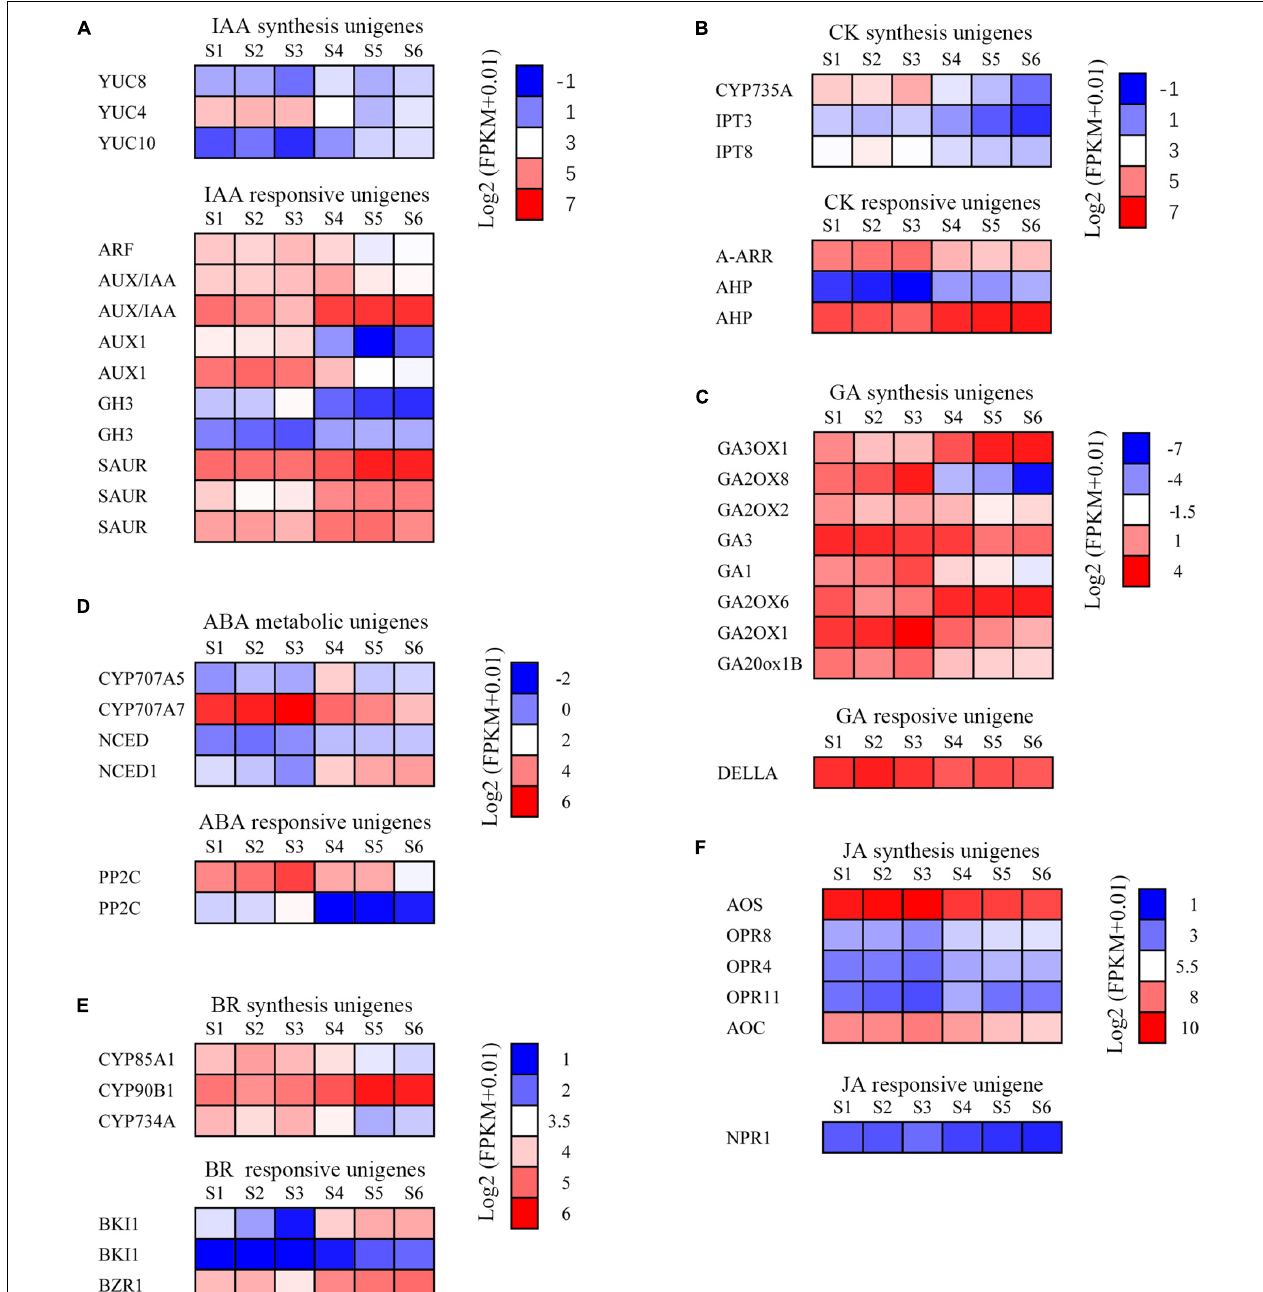
FIGURE 8 | Changes of plant hormone synthesis and signal transduction pathway unigenes during the development of the C . sinense ovule. (A) Expression analysis of auxin synthesis signal transduction pathway unigenes. ARF, auxin response factor; AUX/IAA, auxin/indole acetic acid protein; GH3, Gretchen Hagen; SAUR, small auxin-up RNAs; YUC, indole-3-pyruvate monooxygenase. (B) Expression analysis of cytokinin synthesis and signal transduction pathway unigenes. A-ARR, type-A Arabidopsis response regulator; AHP, histidine-containing phosphotransfer protein; CYP735A, cytokinin hydroxylase; IPT, adenylate isopentenyltransferase. (C) Expression analysis of GA synthesis and signal transduction pathway unigenes. GA, Ent-kaurene oxidase; GA2OX, Gibberellin 2-beta-dioxygenase; GA20ox1B, Gibberellin 20 oxidase 1-B; GA3OX, Gibberellin 3-beta-dioxygenase. (D) Expression analysis of ABA synthesis and signal transduction pathway unigenes. CYP707A5, CP450; abscisic acid 8’-hydroxylase; NCED, 9- cis -epoxycarotenoid dioxygenase; PP2C, protein phosphatase-2C. (E) Expression analysis of brassinosteroid synthesis and signal transduction pathway unigenes. BKI1, BRI1 kinase inhibitor 1-like; BZR1, protein BZR1 homolog 1-like; CYP734A, cytochrome P450 734A; CYP85A1, cytochrome P450 85A1; CYP90B1, cytochrome P450 90B1. (F) Expression analysis of JA synthesis and signal transduction pathway genes. AOC, Allene oxide cyclase; AOS, Allene oxide synthase; NPR1, BTB/POZ domain and ankyrin repeat-containing protein NPR1-like; OPR, 12-oxophytodienoate reductase. The color of each box represents the log 2 (FPKM + 1) value.